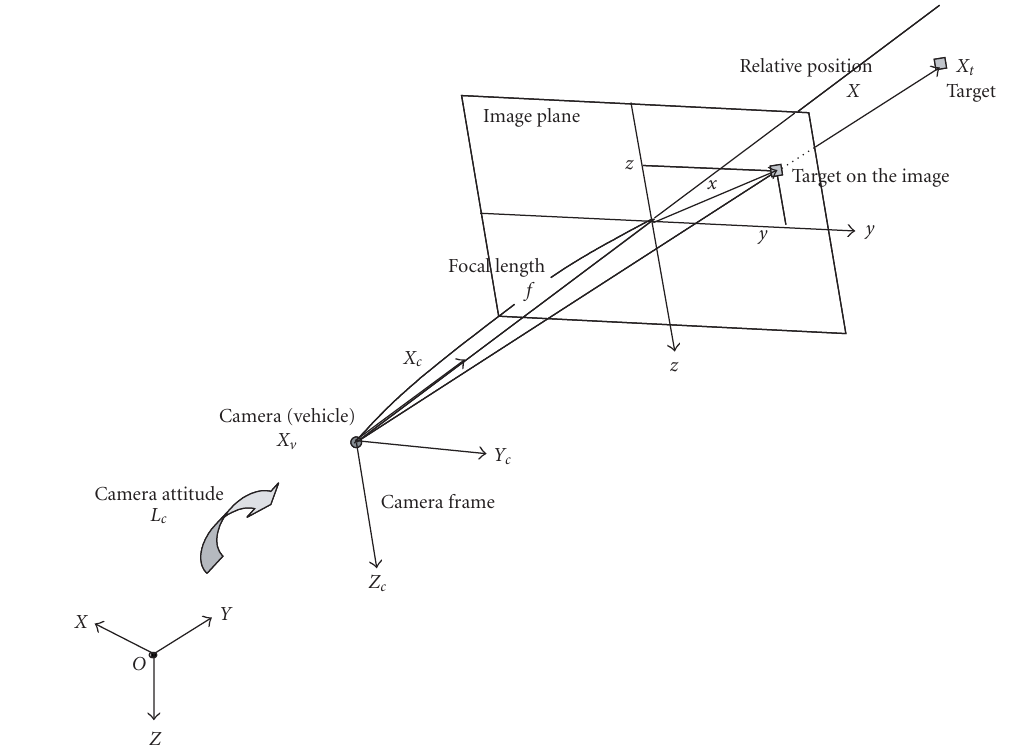
Figure 1: Pinhole camera